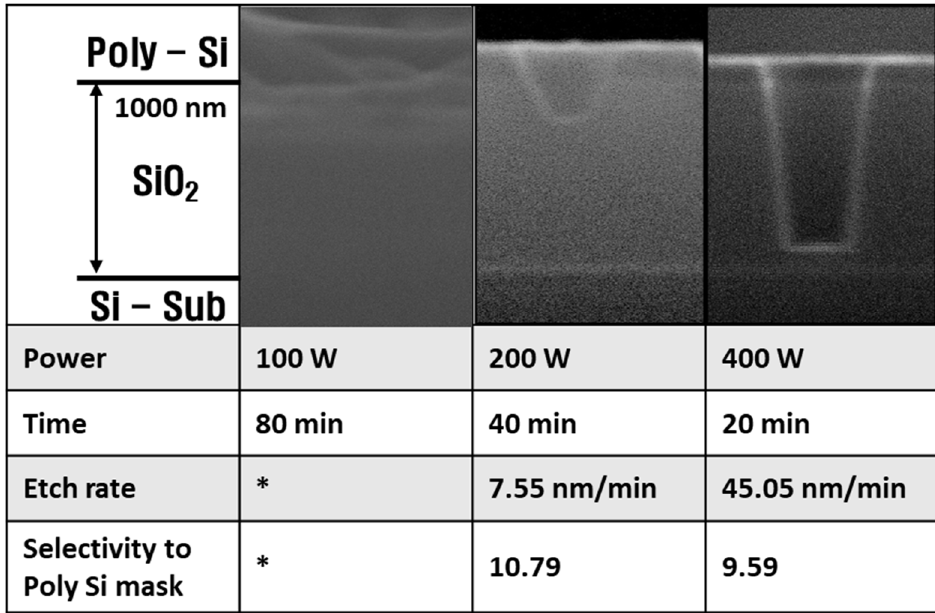
Figure 3. SiO 2 etching profile, etch rate, and selectivity of SiO 2 /Si at increasing power. * Etch rate cannot be